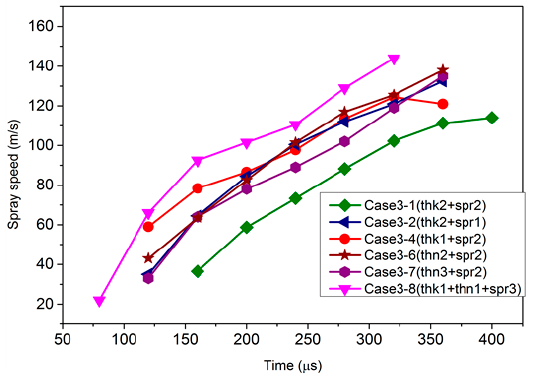
Figure 13. Comparison of the spray speed results in Type 3 DPIs.